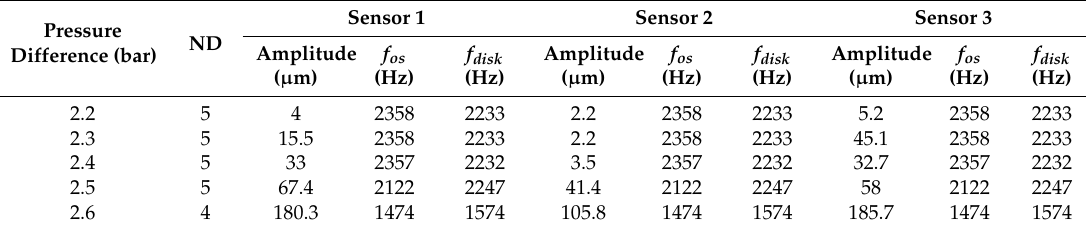
Table 3. Results for the first prototype at RPM nominal .